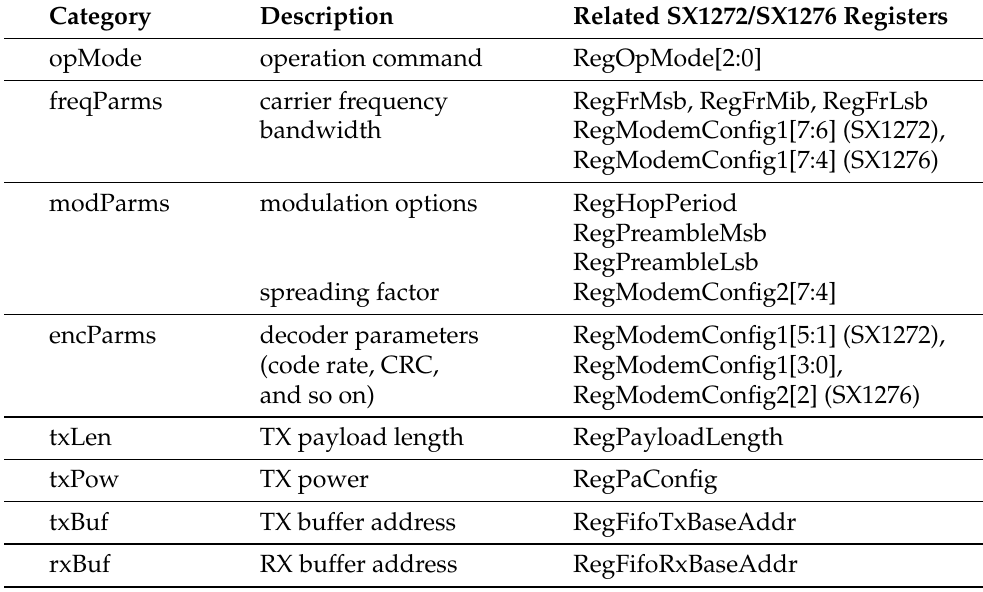
Table 2. Categorization of the registers of SX1272 and